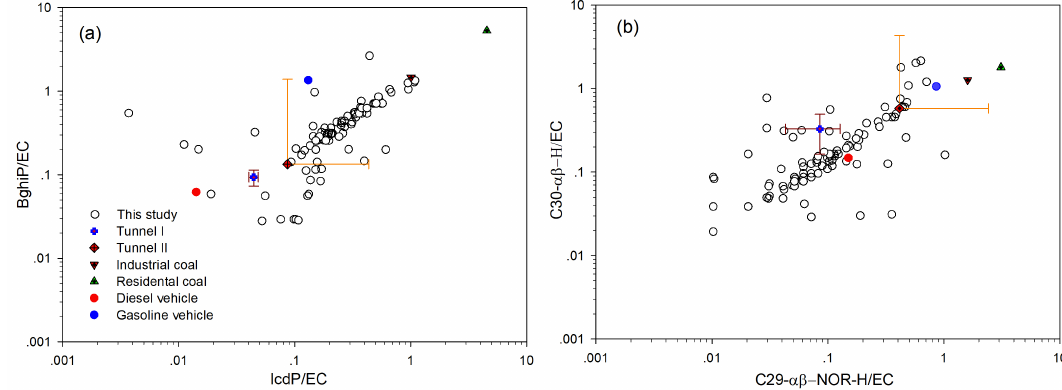
Figure 5. Ratio–ratio plots of two pairs of characterized species (IcdP/BghiP and C29- αβ -NOR-H/C30- αβ -H) normalized by EC and pub- lished source profiles. (tunnel I: Yu et al., 2011; tunnel II: He et al., 2009; residential coal: Zhang et al., 2008; industrial coal: Zhang et